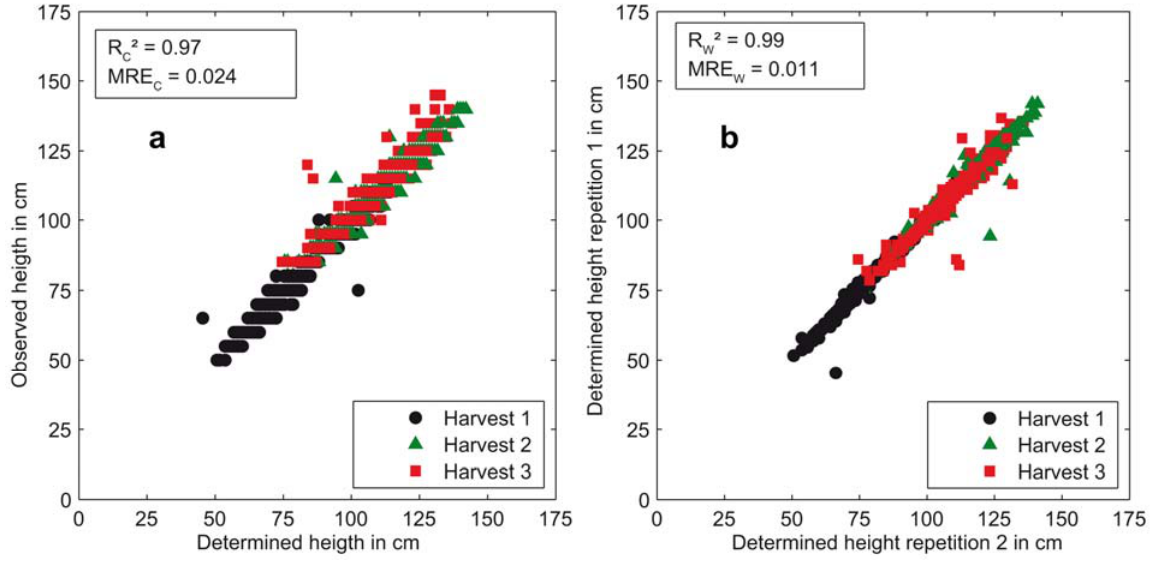
Figure 8. ( a ) Accuracy and ( b ) technical repeatability of plant height determination based ² denotes the coefficient of correlation of on light curtain data of the year 2011 and 2012. R c calibration, MRE the mean relative error of calibration, R w2 the coefficient of correlation c the mean relative error of repetition and Harvest the three different of repetition, MRE w timepoints of reference data